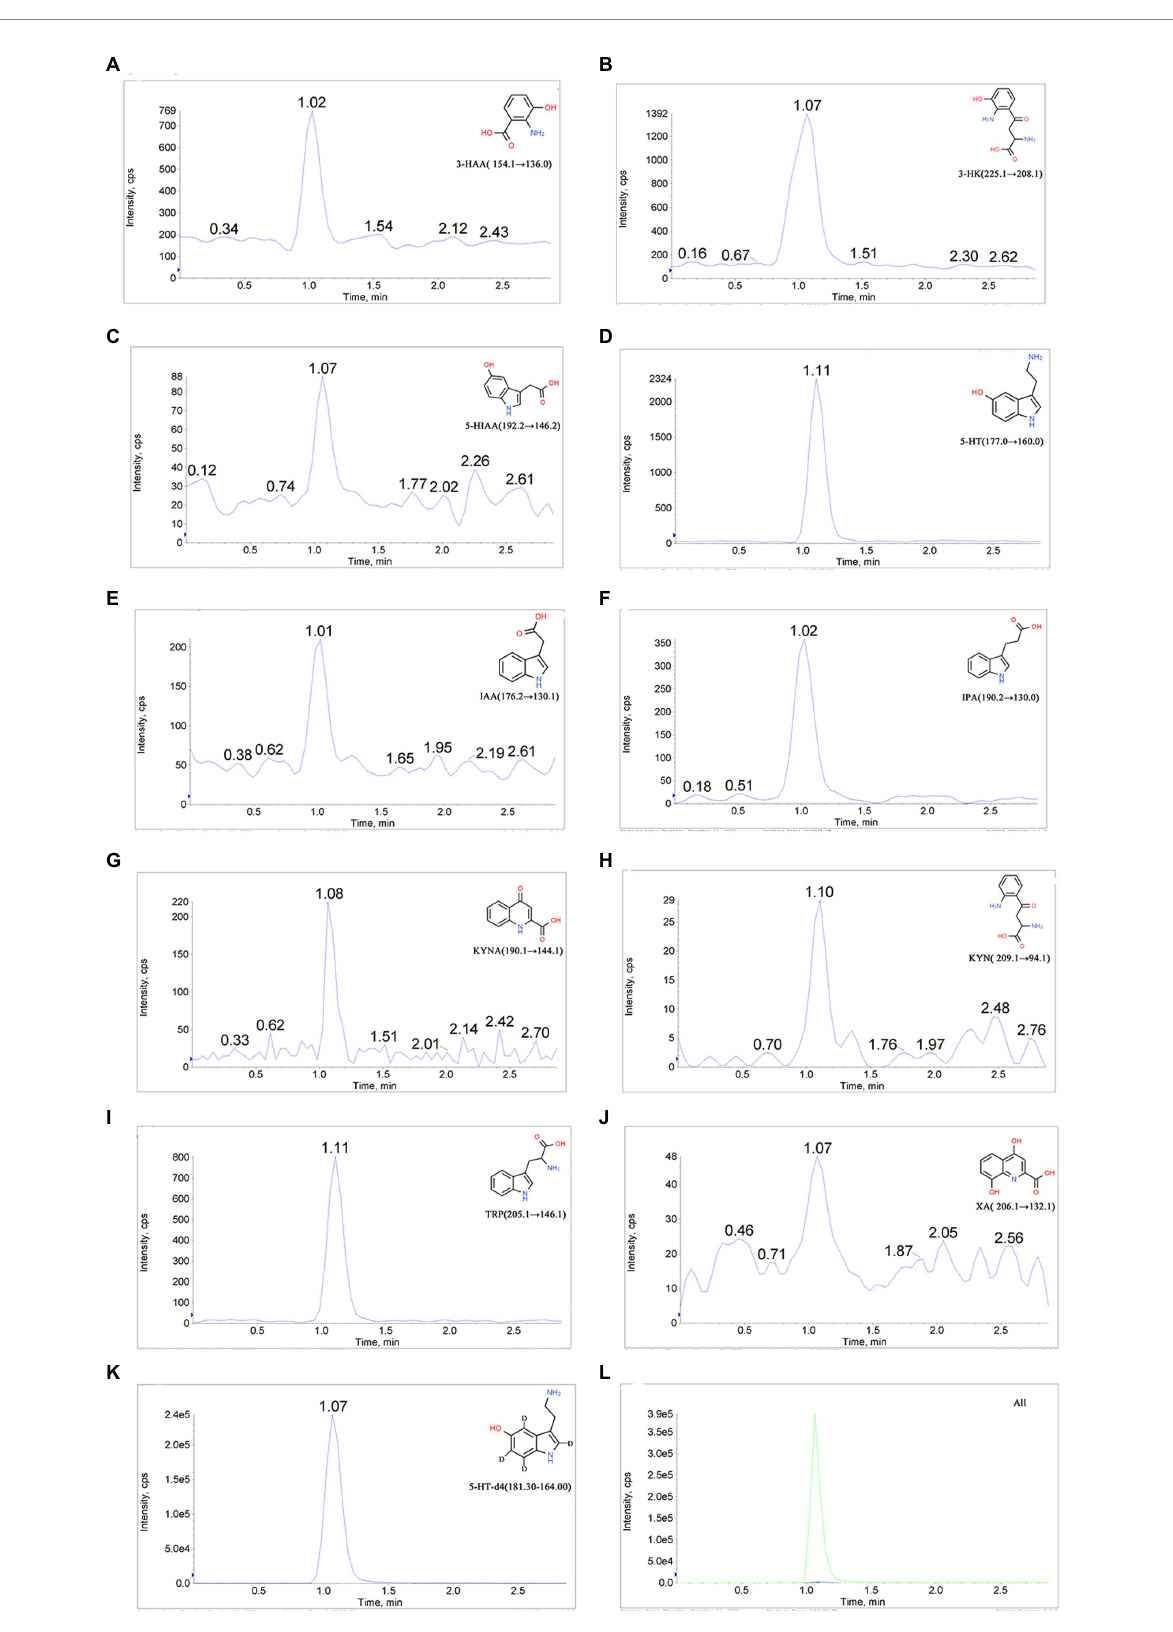
FIGURE 4 Chromatograms of 10 analytes and the internal standard. (A) 3-Hydroxyanthranilic acid (3-HAA), (B) 3-hydroxykynurenine (3-KH), (C) 5-hydroxyindole- 3-acetic acid (5-HIAA), (D) 5-hydroxytryptamine (5-HT), (E) 3-indole-acetic acid (IAA), (F) indole-3-propionic acid (IPA), (G) kynurenic acid (KYNA), (H) kynurenine (KYN), (I) tryptophan (TRP), (J) xanthurenic acid (XA), (K) 5-hydroxytryptamine-d4 (5-HT-d4), and (L) total ion